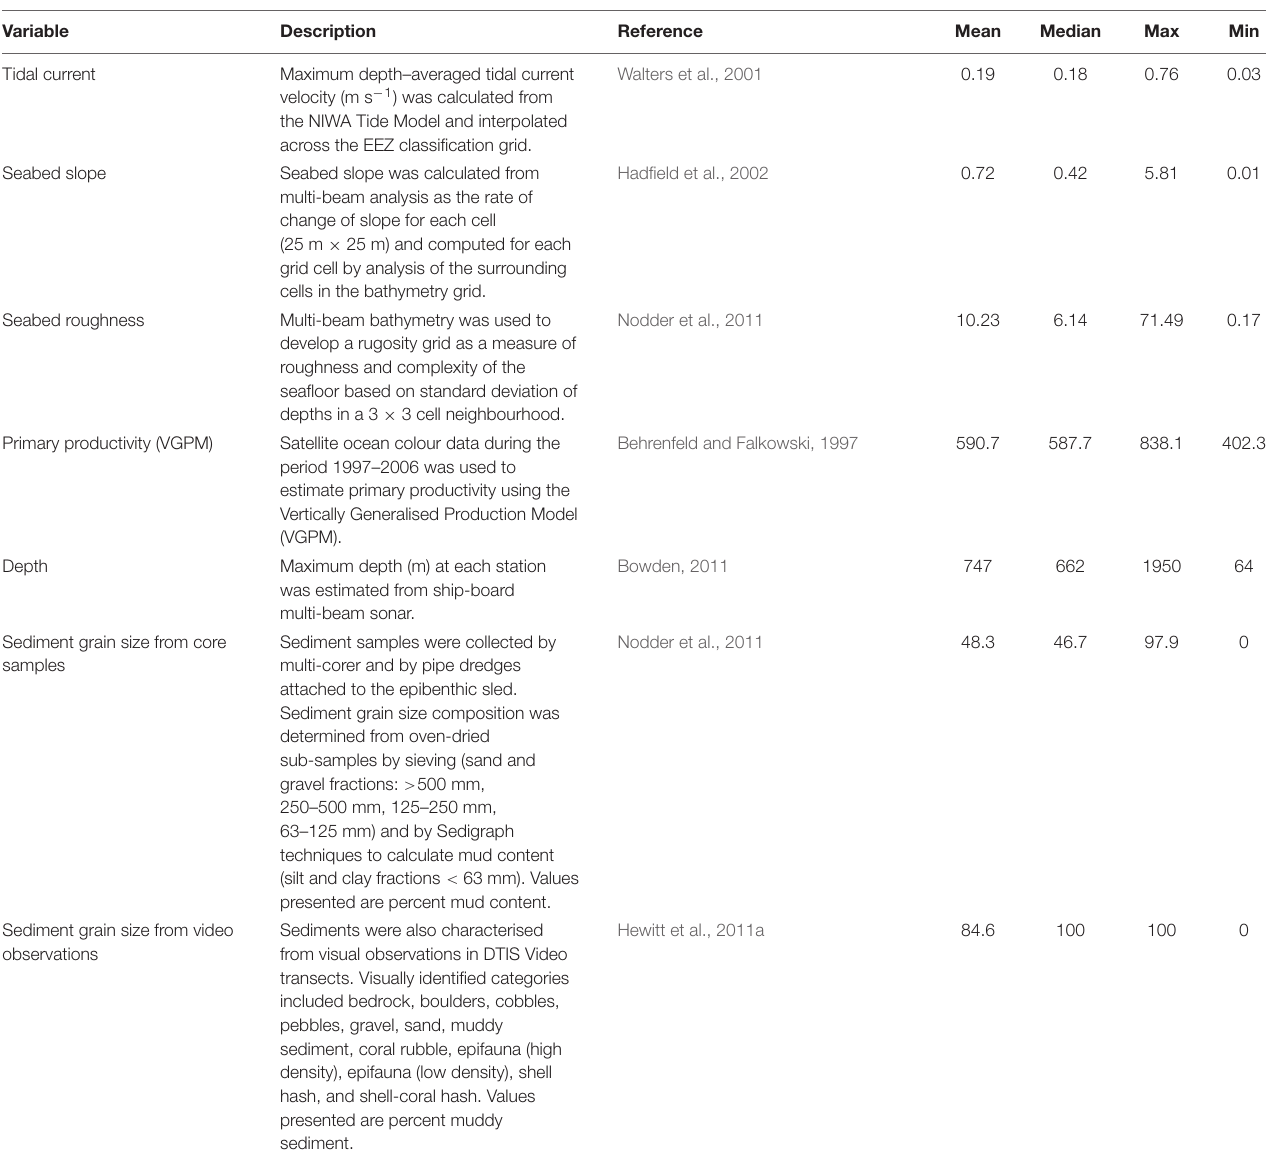
TABLE 1 | Environmental variables available for Chatham Rise and Challenger